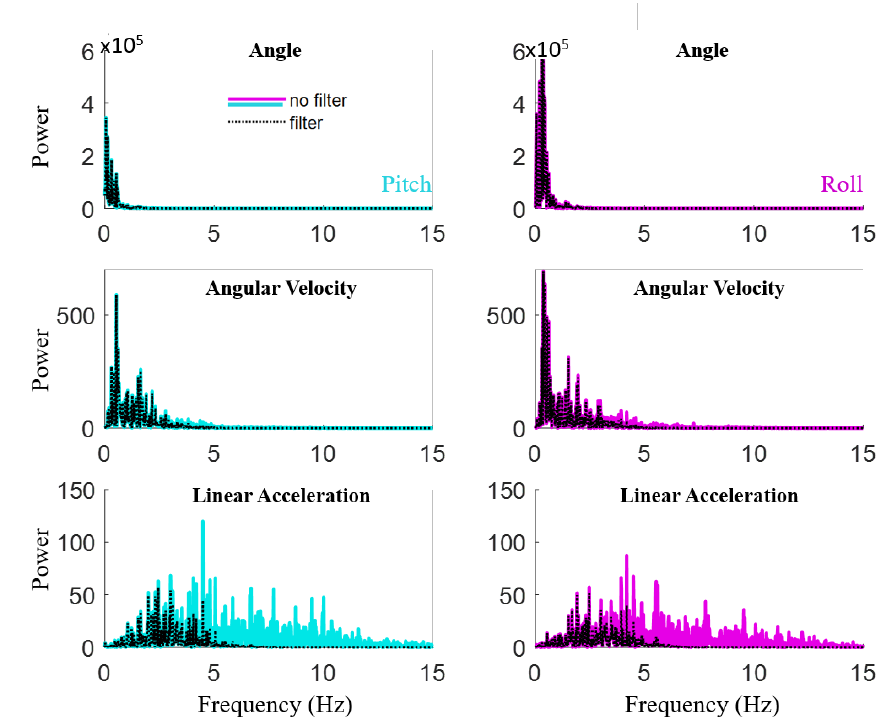
Figure 12. Fast Fourier transforms (FFT) comparing filtered and unfiltered Xsens IMU signals demonstrate that a slower sampling rate would likely be sufficient for the angle and angular velocity-based metrics because the frequency contents are below the low pass filter 5Hz